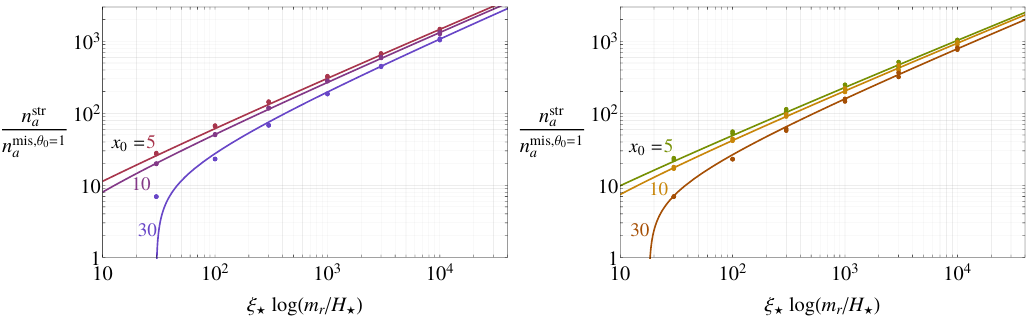
Figure 24: The ratio between the axion number density from strings and from mis- = 1) as a function of ξ α = 4,6 (left and right panels alignment (with θ (cid:63) log (cid:63) for 0 respectively). The data points are simulation results, while the lines are the analytic = 2.08, c = 0.13, c = 1.35 fit from estimate in eq. (36) with coefficients c m V n